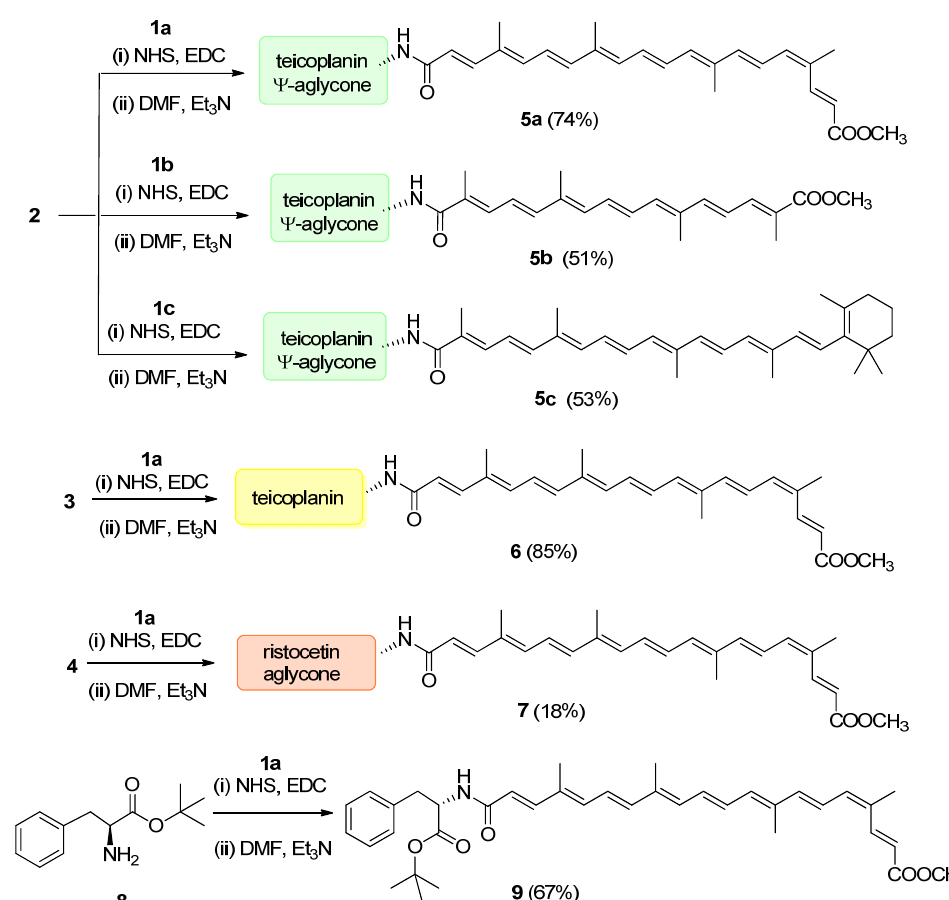
Figure 3. Conjugation of apocarotenoids 1a – c to the N -terminal amino group of glycopeptide derivatives 2 – 4 and to L -phenylalanine derivative 8 . (NHS: N -hydroxysuccinimide; EDC: 1-ethyl-3-(3- dimethylaminopropyl)carbodiimide) .